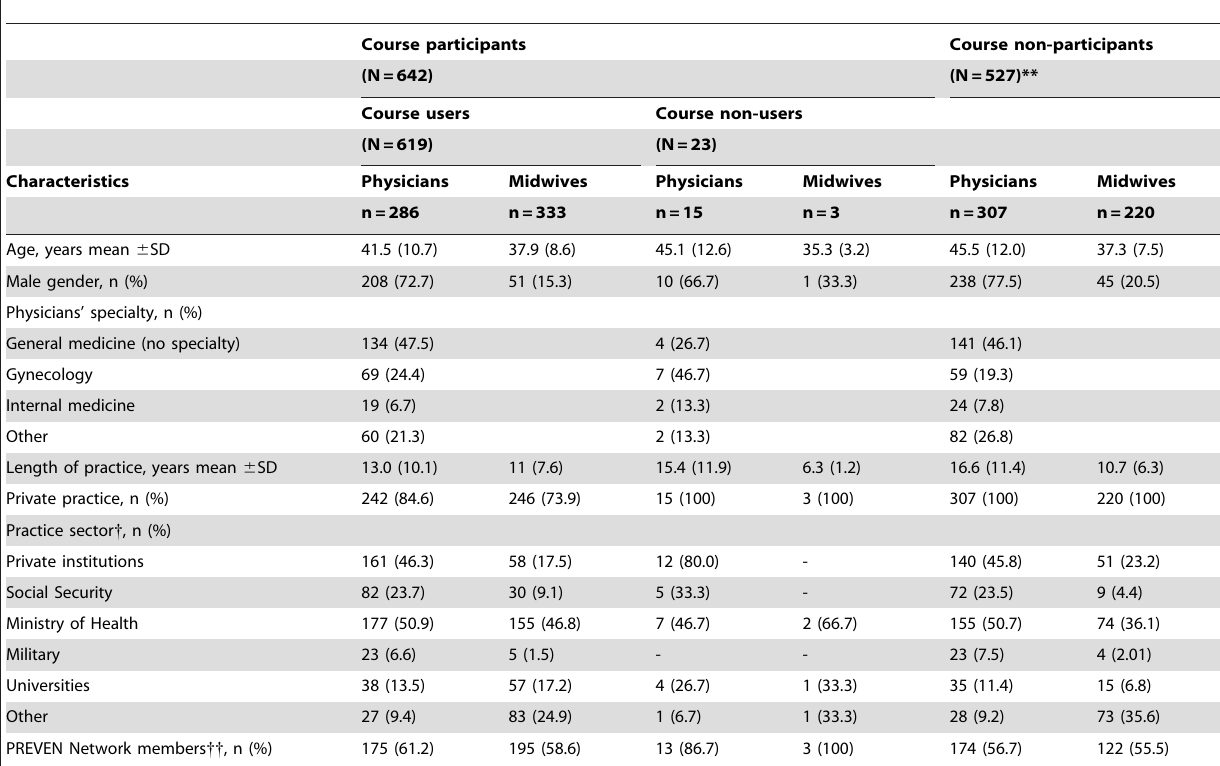
Table 1. Characteristics of physician and midwife participants and non-participants in the STD I-CE